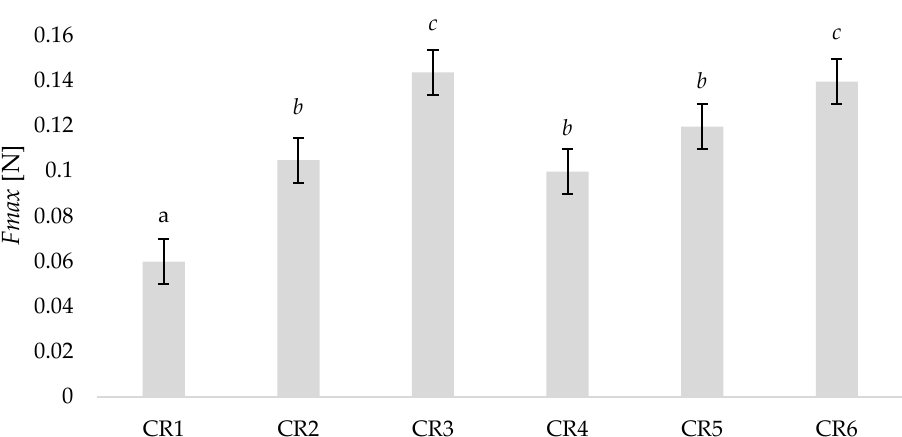
Figure 10. Mean detachment force Fmax (Newtons) for controlled release formulations CR1–CR6 as measured by a TA.XTplus texture analyser ( n = 3). Formulations with significant differences in mean detachment force (at the 95% level of confidence; p -value < 0.05) are represented by different superscripts ( a , b or c ).